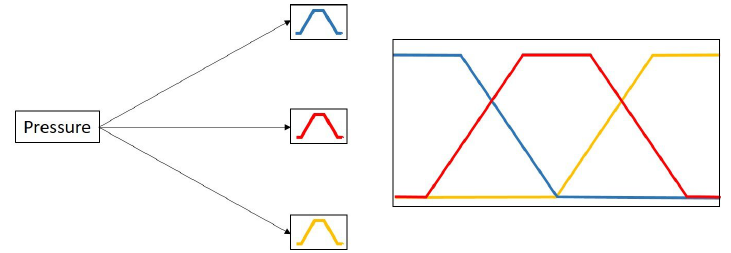
Figure 1. Example of three trapezoidal membership